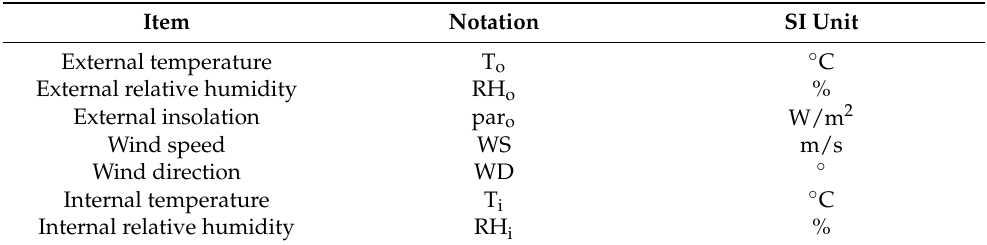
Figure 2. Location and structure of the greenhouse investigated in this study. Table 1. IoT monitoring data collected in this study for model-validation purposes (20 May–20 July 2019 at a 10 min scale).